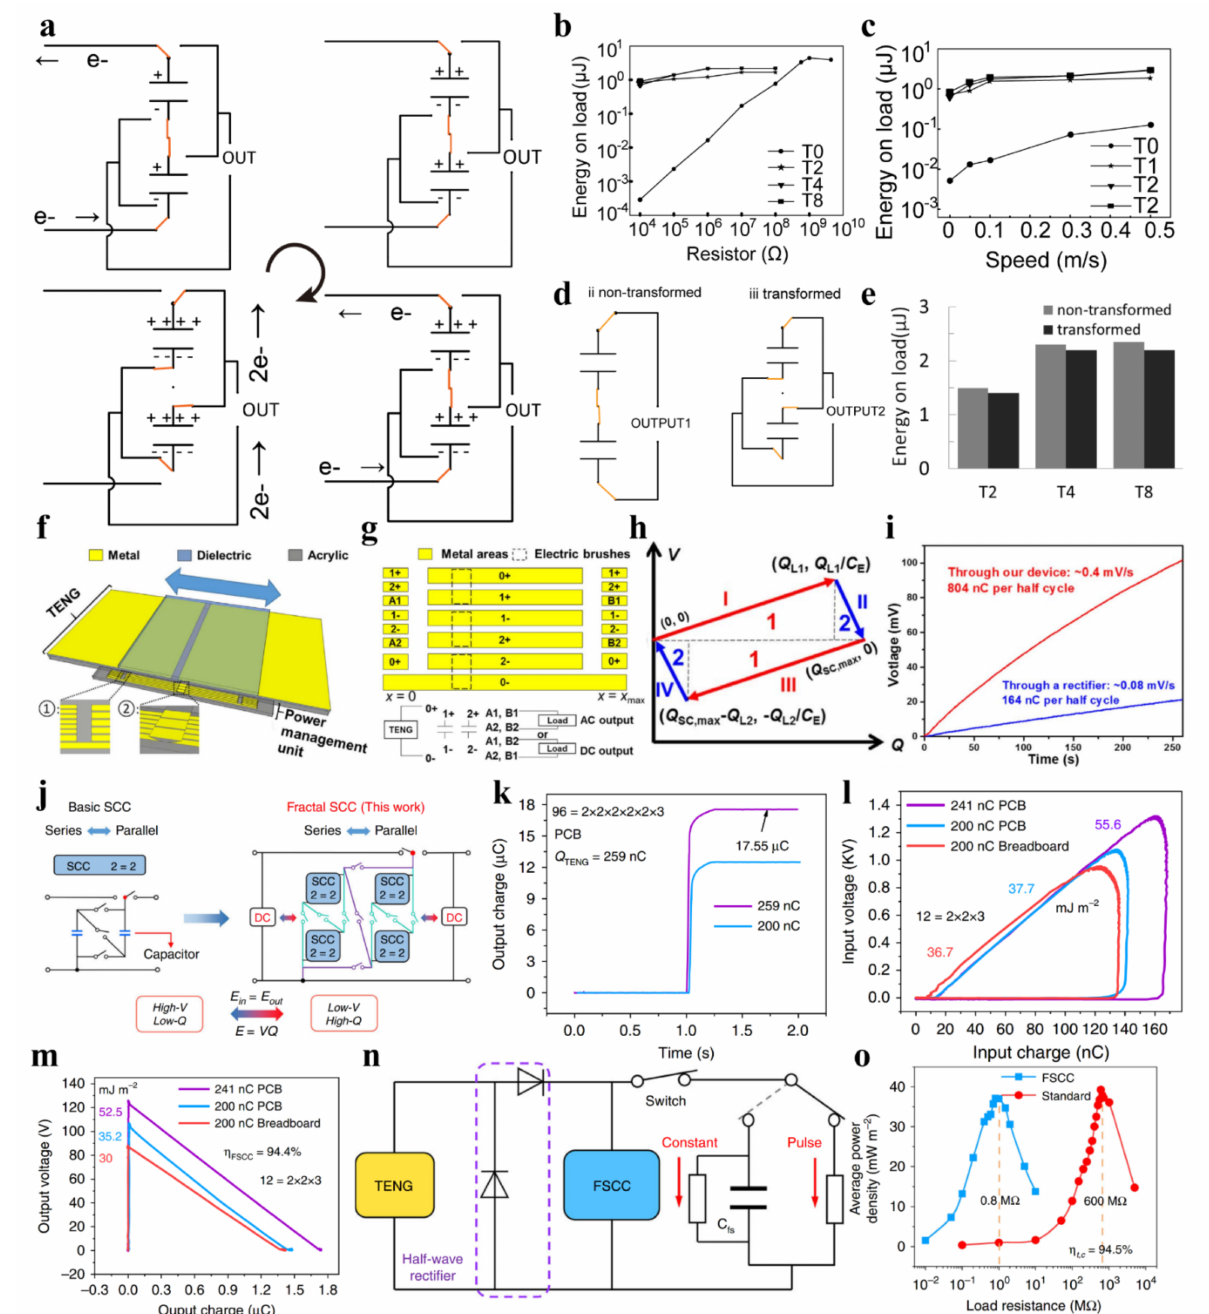
Figure 5. Switch capacitor convertor with travel switch. ( a ) The switching process and charge transfer of the first switch capacitor convertor for TENG. ( b ) Output energy on different load with/without power management. ( c ) Output energy on load at different speed with/without power management. ( d ) Electrical connection of transformed and non-transformed circuit. ( e ) Transformed and non- transformed energy output [60]. ( f ) Structure of the inductor-free triboelectric management method. ( g ) Structure of the travel switch. ( h ) V - Q curve of the managed energy output. ( i ) Comparison of the charged voltage between rectifier circuit and the power management circuit. Reproduced with permission [71]. Copyright 2017, Elsevier. ( j ) Fractal design. ( k ) Comparison of output charge between short-circuit and fractal design based switched-capacitor-convertors (FSCC) circuit. ( l ) Input V - Q curve and ( m ) output V - Q curve. ( n ) Electrical connection of constant mode and pulse mode with FSCC. ( o ) Comparison of dependence of average power density on load between FSCC and standard circuit. Reproduced with permission [64]. Copyright 2020, Nature